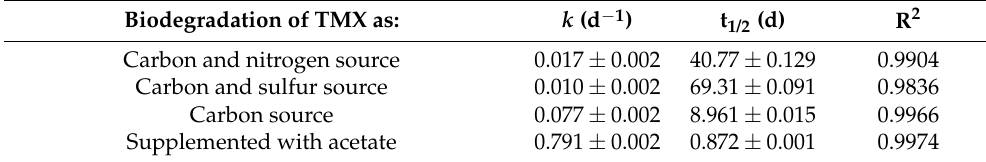
Table 1. First-order rate constant ( k ) and half-life (t 1/2 ) for degradation of TMX (10.8 mg L − 1 ) by L. portucalensis F11.